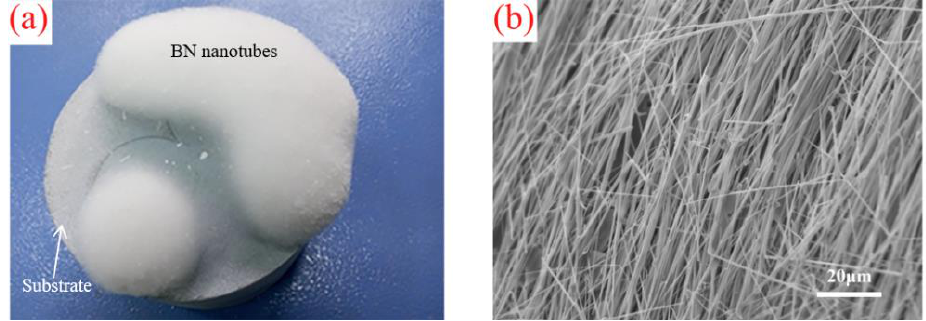
Figure 1. Photograph ( a ) and SEM photograph ( b ) of the obtained boron nitride (BN) nanotubes.